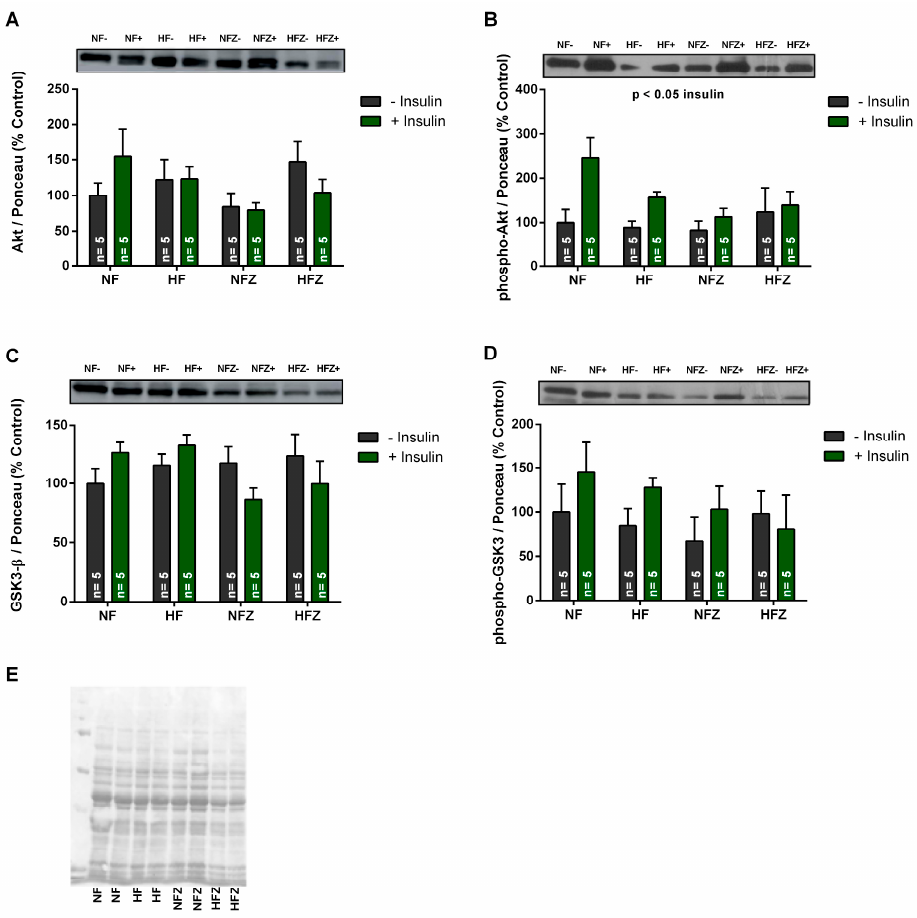
Figure 3. Effect of supplementation with ZnCl 2 on the content and phosphorylation of Akt and GSK3- β in soleus muscle. Total Akt ( A ); phospho-Akt (Ser 473 ) ( B ); total GSK3- β ( C ); phospho-GSK3- β (Ser 9 ) ( D ); ponceau staining used for normalization ( E ). Two-way ANOVA: total Akt (chow, p > 0.05; insulin, p > 0.05; interaction p > 0.05); phospho-Akt (Ser 473 ) (chow, p > 0.05; insulin, p < 0.05; interaction, p > 0.05); total GSK3- β (chow, p > 0.05; insulin, p < 0.05; interaction, p > 0.05); and, phospho-GSK3- β (Ser 9 ) (chow, p > 0.05; insulin, p > 0.05; interaction, p > 0.05).